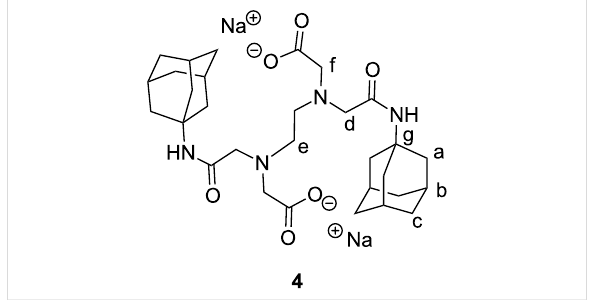
Figure 5: Structure of the ditopic guest ADAdim 4 .